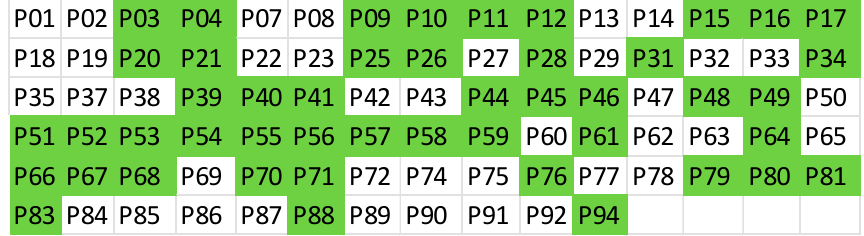
Figure 5. Selected lines (Green Color) to potentially be replaced for p m1 = 10%. Infrastructures 2019 , 4 , x FOR PEER REVIEW